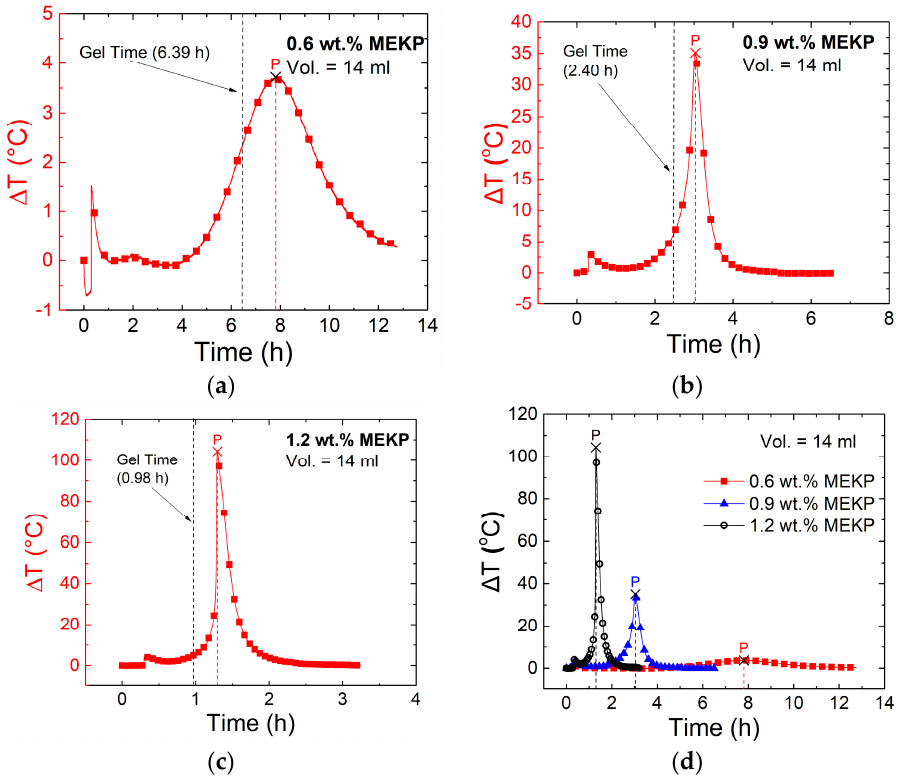
Figure 4. VER thermograms (14 mL) during curing for different MEKP concentrations: ( a ) 0.6 wt.%, ( b ) 0.9 wt.%, ( c ) 1.2 wt.%, and ( d ) superposition of all thermograms.